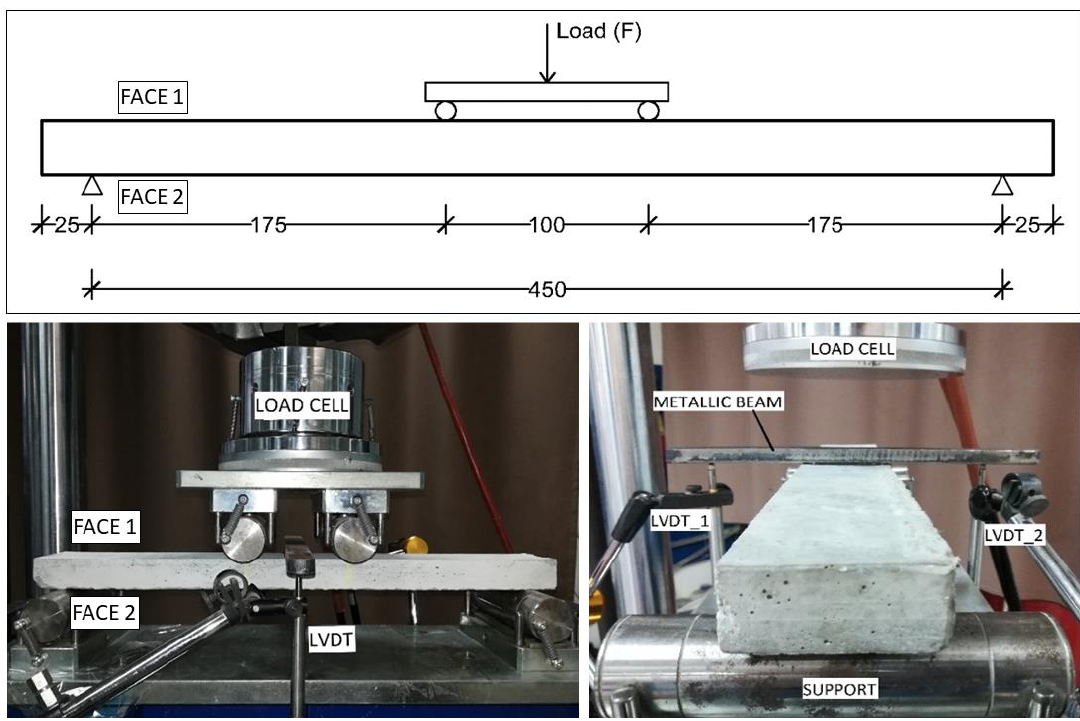
Figure 5. Experimental set-up details about the four-point bending tests.